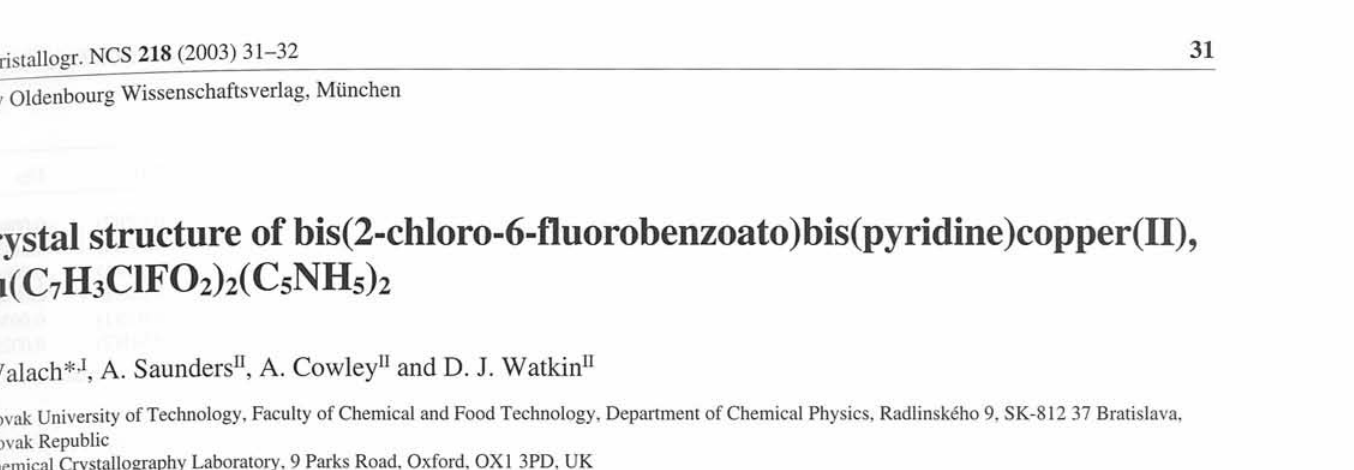
Table 1. Data collection and handling. Crystal: